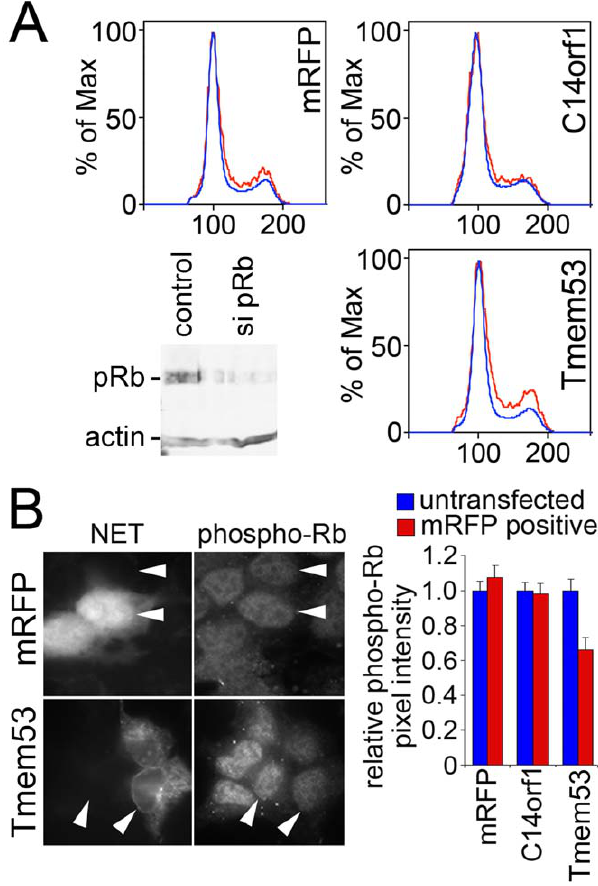
Figure 4. pRb is also involved in NET4/Tmem53 effects. (A) pRb was knocked down by siRNA in HEK293T cells subsequently transfected with NETs. Cell cycle profiles are shown for these cells expressing NET4/ Tmem53 or controls of mRFP alone or NET51/C14orf1 that had no effect in the original flow cytometry screen. The 2N accumulation effect of NET4/Tmem53 on the cell cycle profile observed in HEK293T cells was lost when pRb levels were reduced. The knockdown of pRb is confirmed in the lower left corner. (B) Photomicrographs of cells overexpressing the RFP alone control or NET4/Tmem53. Cells were stained with an antibody that recognizes pRb phosphorylated on serine 780. NET/mRFP signal is shown in the left panels to identify transfected cells and phospho-pRb staining in the right panels. In each panel two adjacent cells are marked by arrowheads, one transfected and the other not transfected. All micrographs were taken at the same exposure time. The graph on the right shows quantification of the pixel intensity for the phospho-pRb staining. The pixel intensity for untransfected controls internal to each micrograph was set to 1 and average relative values from 40 transfected cells and 40 untransfected cells for each transfection are shown with standard errors.